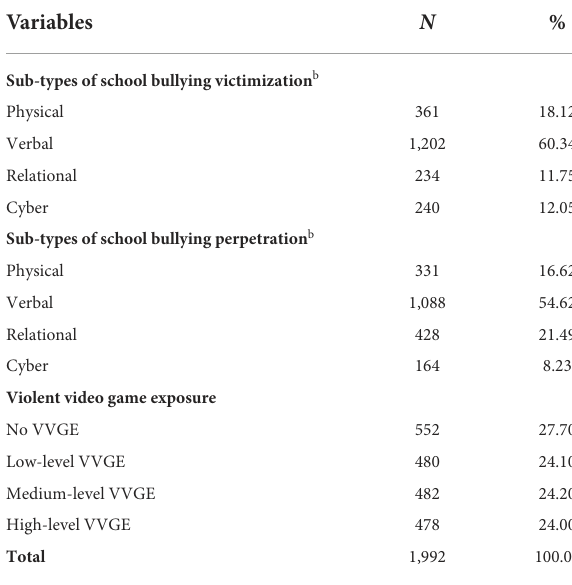
TABLE 1 Demographic characteristics and the prevalence of sub-types of school bullying and VVGE of the